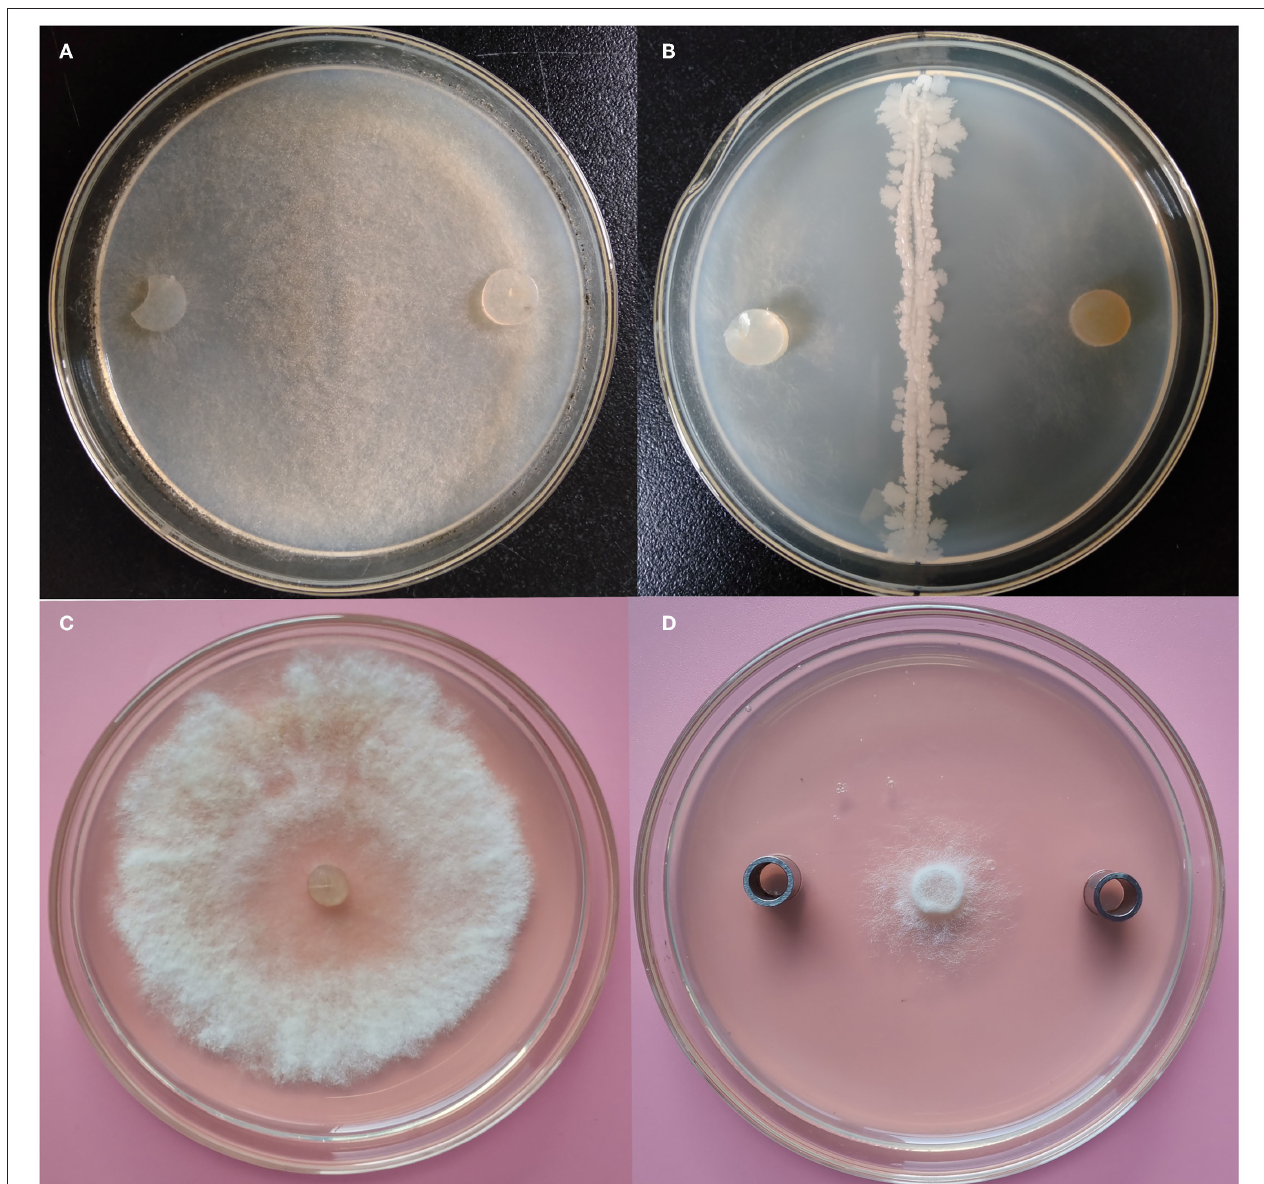
FIGURE 1 | Antifungal evaluation of Bacillus K1 against Botrytis cinerea . (A) B. cinerea on potato dextrose agar (PDA) as control. (B) Growth inhibition of B. cinerea after antagonist with K1. (C) B. cinerea on PDA as control. (D) Growth inhibition of B. cinerea after antagonist with K1